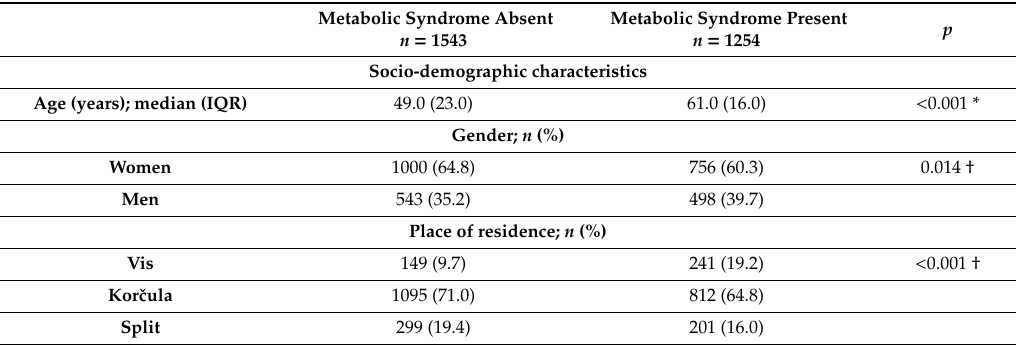
Table A1. Subjects’ characteristics according to the presence or absence of the metabolic